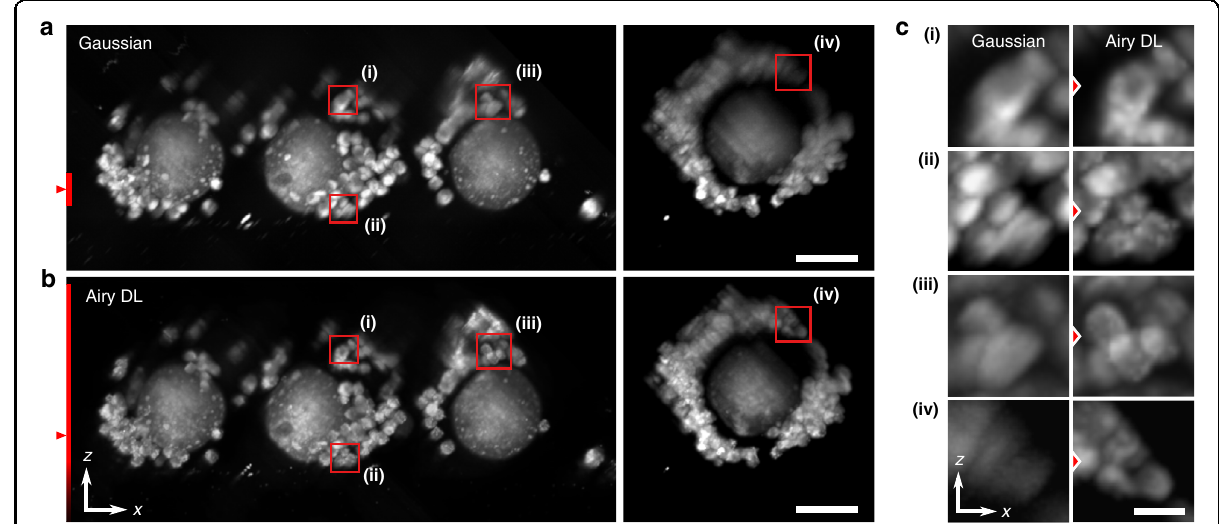
Fig. 5 Cross-sectional LSM images of mouse cumulus – oocyte complexes (COCs) with Gaussian and Airy beams with deep-learning deconvolution. a , b Wide fi eld cross-sectional maximum intensity projections (range: 50 μ m). c Zoomed-in regions of cumulus cells (i – iv) emphasising the enhancement of Airy DL over Gaussian LSM from corresponding regions in ( a , b ) marked by red rectangles. The red line on the left of ( a , b ) shows the theoretical DOF of the Gaussian and Airy beams. The red triangle marks the focal position. Scale bars are a , b 50 μ m and c 10 μ